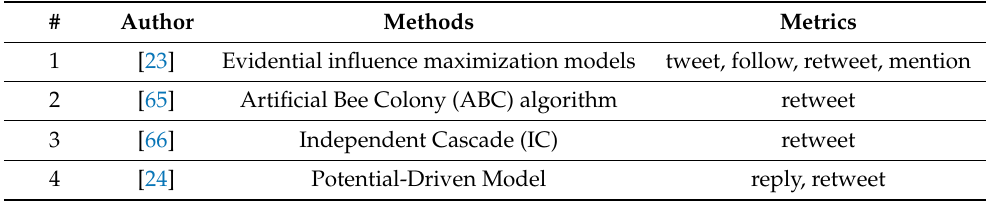
Table 6. Studies of influence maximization on